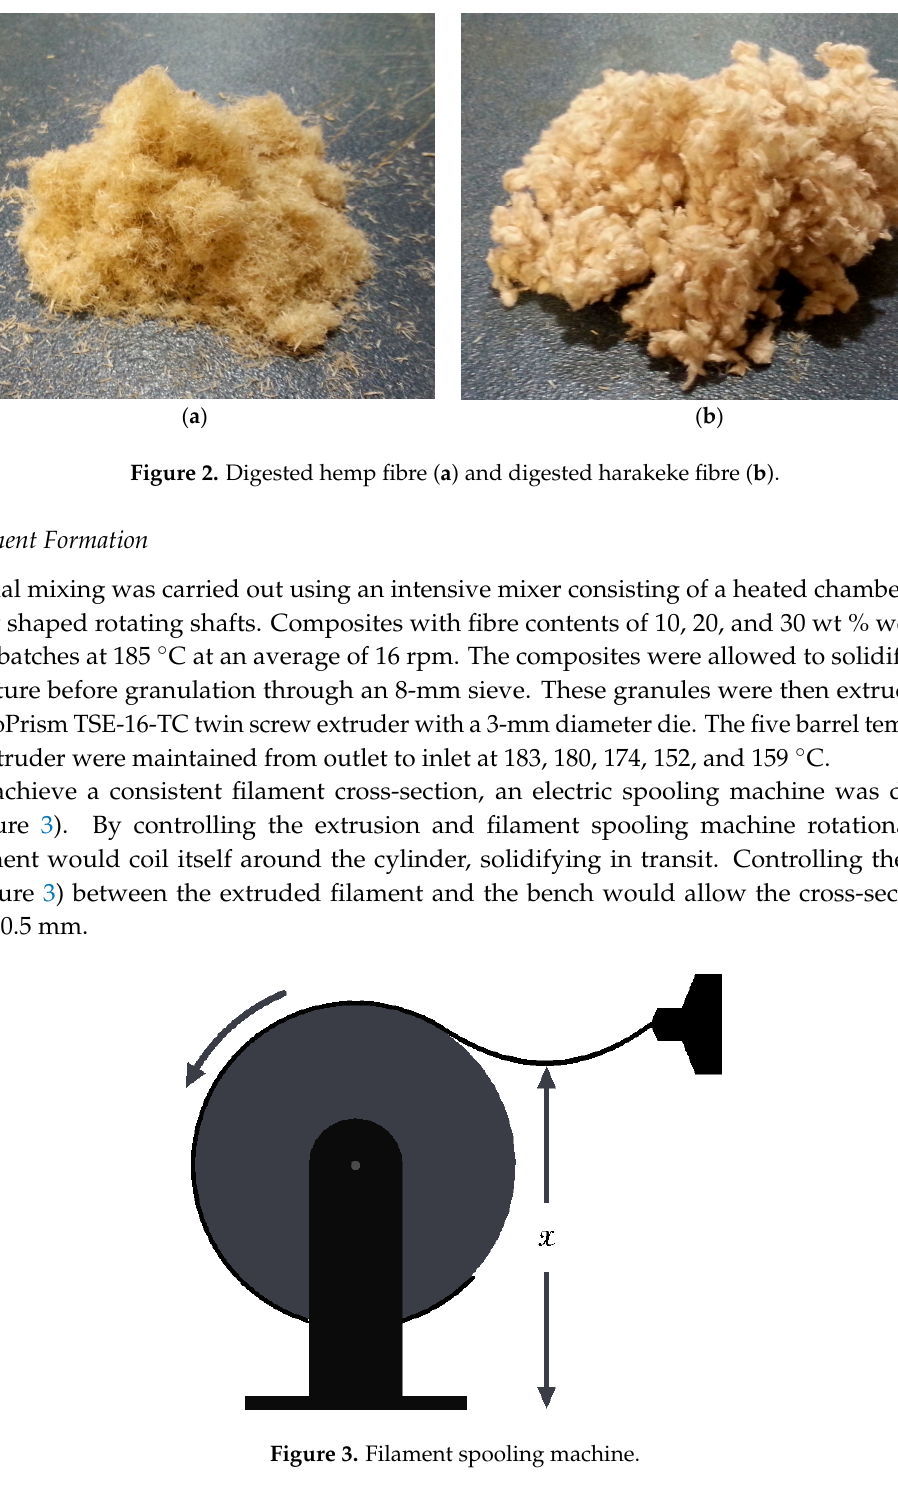
Figure 3. Filament spooling machine.